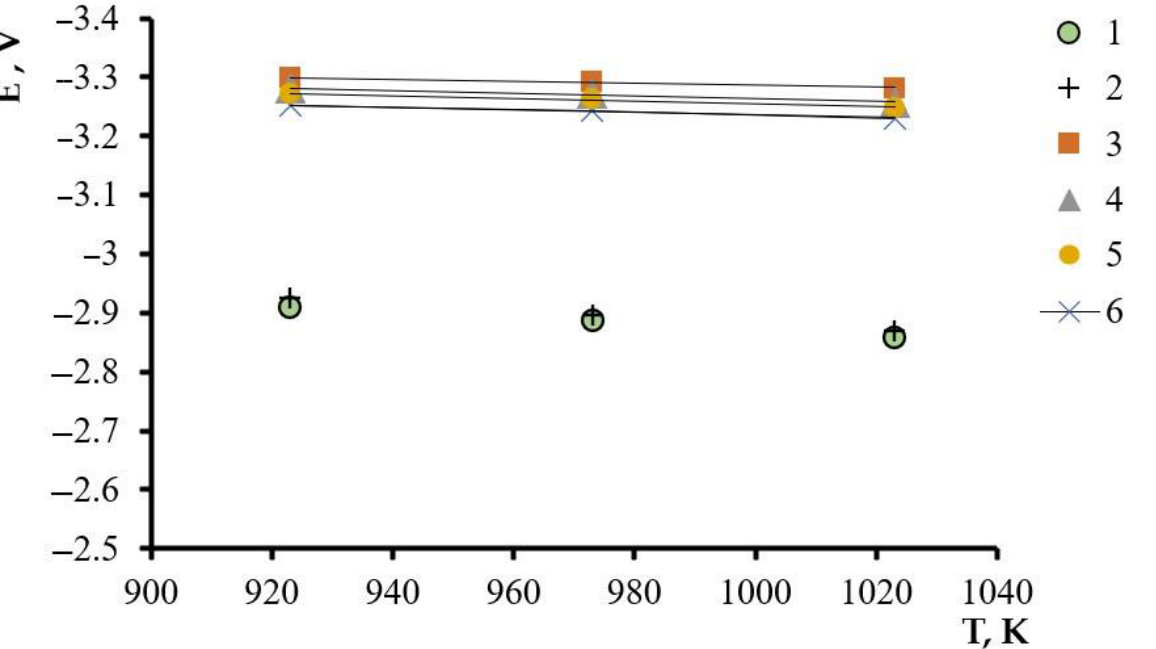
Figure 4. Temperature dependence of electrode potentials of iron in the LiF – BeF 2 melt. The values of conditional standard potentials of iron: 1 — present paper; 2 — [32]. Equilibrium potentials at iron concentrations in the melt, wt.%: 3 — 0.0338; 4 — 0.0559; 5 — 0.0651; 6 — 0.0992.